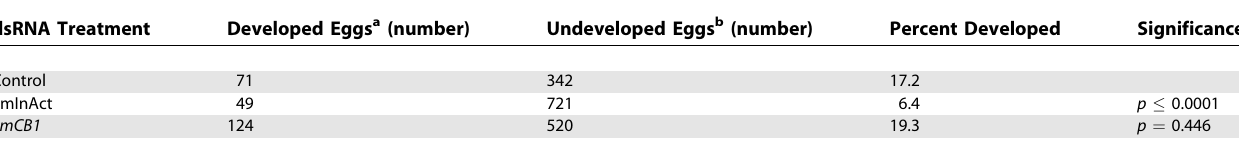
Table 1. Comparsion of the Development of Eggs Soaked in SmInAct dsRNA versus SmCB1 dsRNA dsRNA